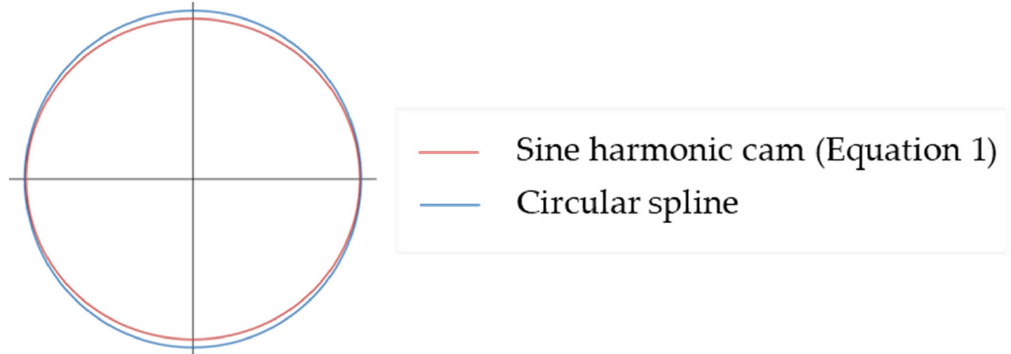
Figure 2. Sinusoidal harmonic cam curve. The deviation coefficient ( λ ) can be obtained through Equation (3) as a variable representing the kinetic characteristics of the harmonic